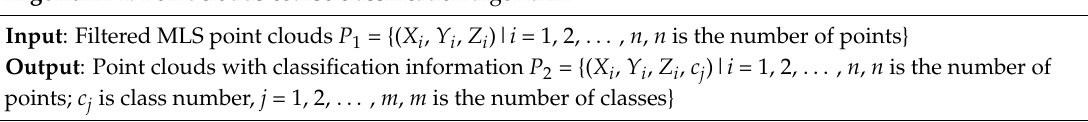
Algorithm 1. Point clouds coarse classification